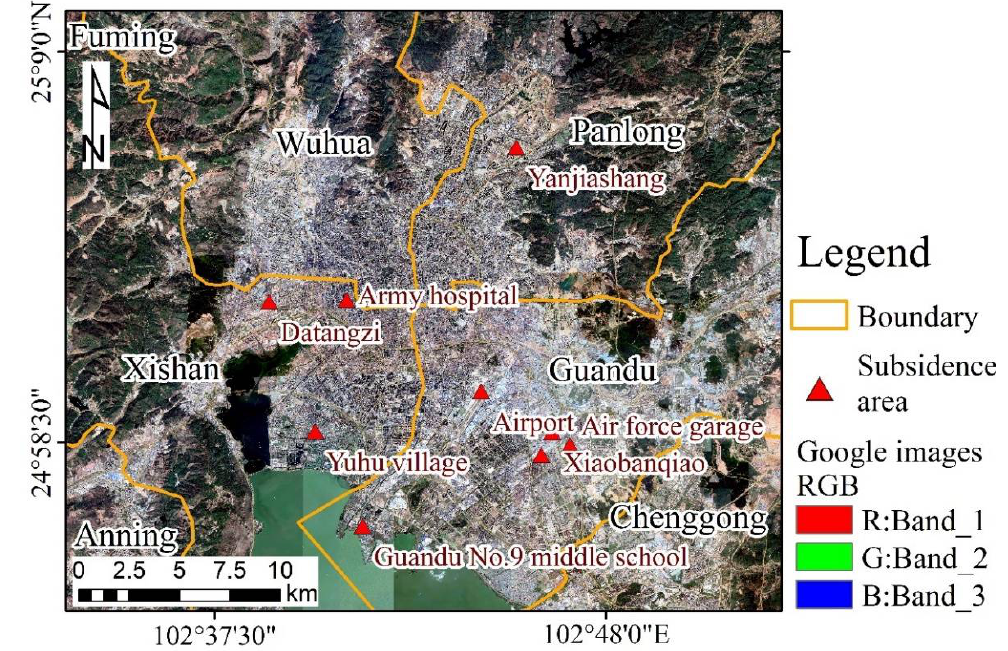
Figure 2. Location distribution of second-class level survey of the study area (relevant data superimposed on Google Image).